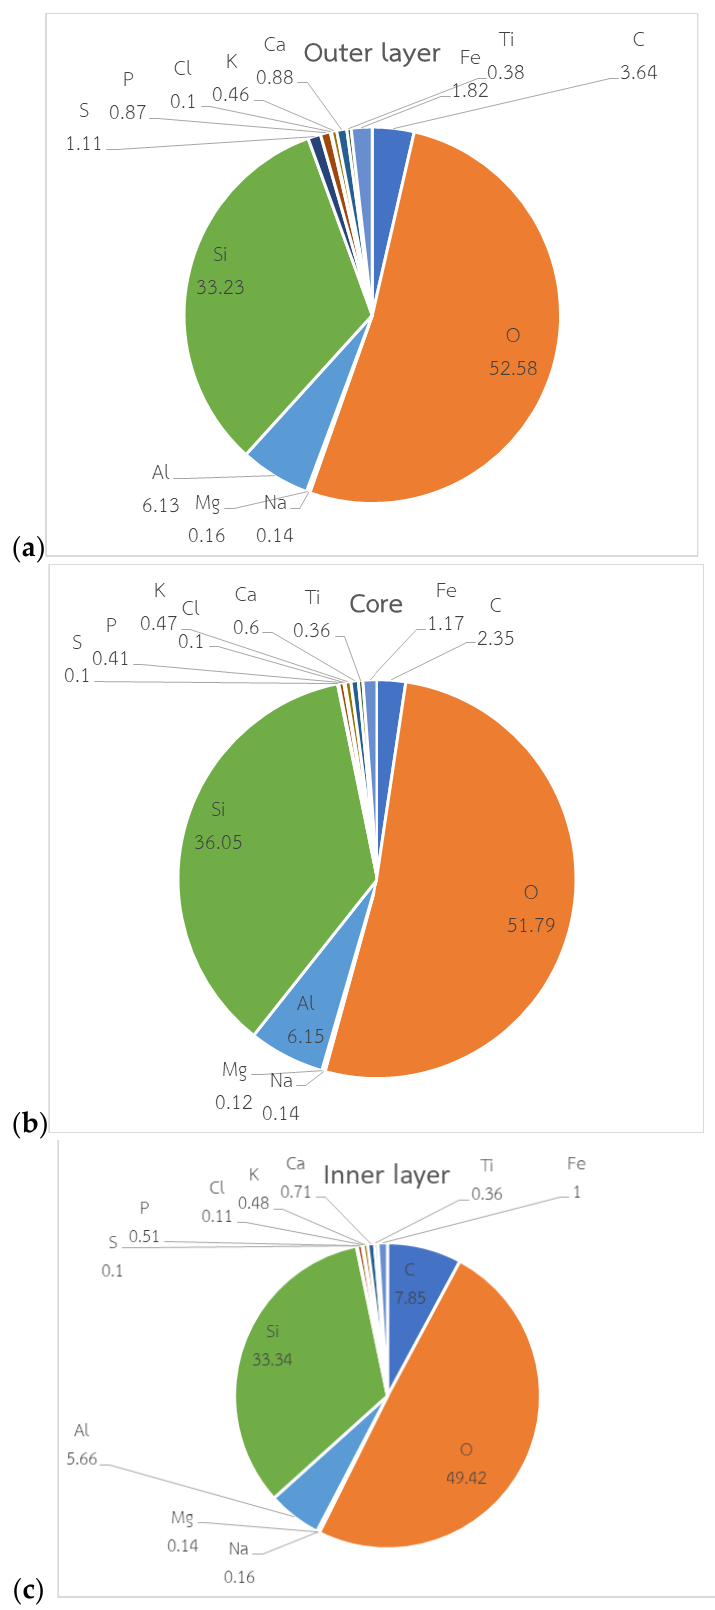
Figure 4. Average elemental composition of samples analyzed by SEM-EDS for ( a) outer layer, ( b) core, and ( c ) inner layer.